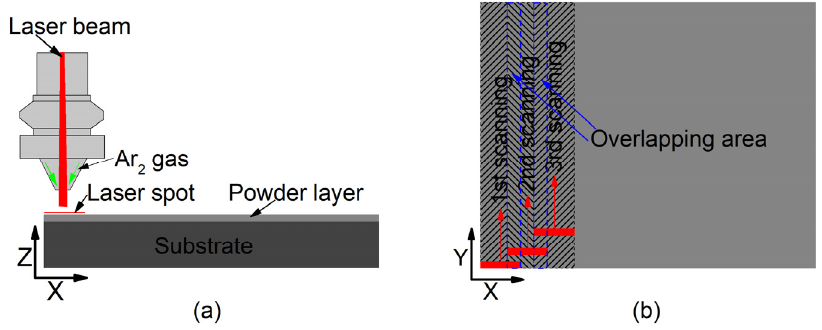
Figure 1. Laser cladding synthesis: ( a ) X–Z direction view; ( b ) X–Y direction view.